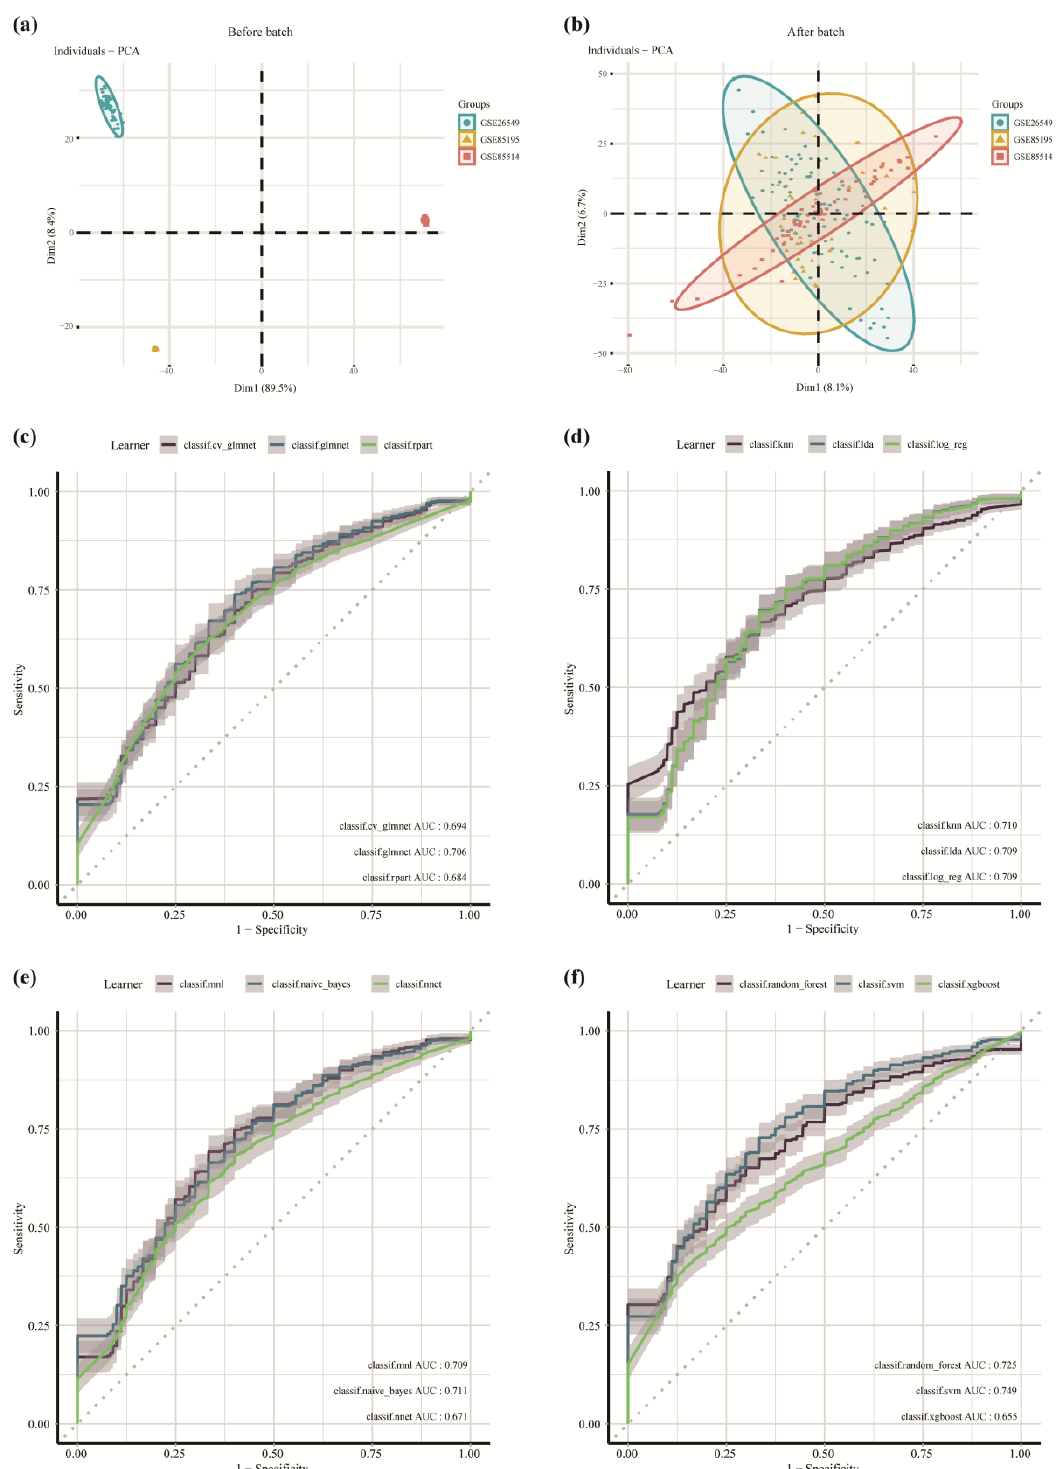
Figure 3. Development and verification of the diagnostic efficiency-based classifier using multiple machine learning algorithms. ( a ) Principal component analysis (PCA) before removing the batch effects. ( b ) PCA after removing the batch effects. ( c ) Machine learning algorithms: cv. glmnet (10-fold cross-validation glmnet), glmnet, rpart (regression partition trees). ( d ) Machine learning algorithms: KNN (k-nearest neighbor), LDA (linear discriminant analysis), log_reg (logistic regression). ( e ) MNL (multinomial logit model), naïve Bayes, NNet (neural network). ( f ) random forest, SVM (support vector machines), XGBoost (extreme gradient boosting).